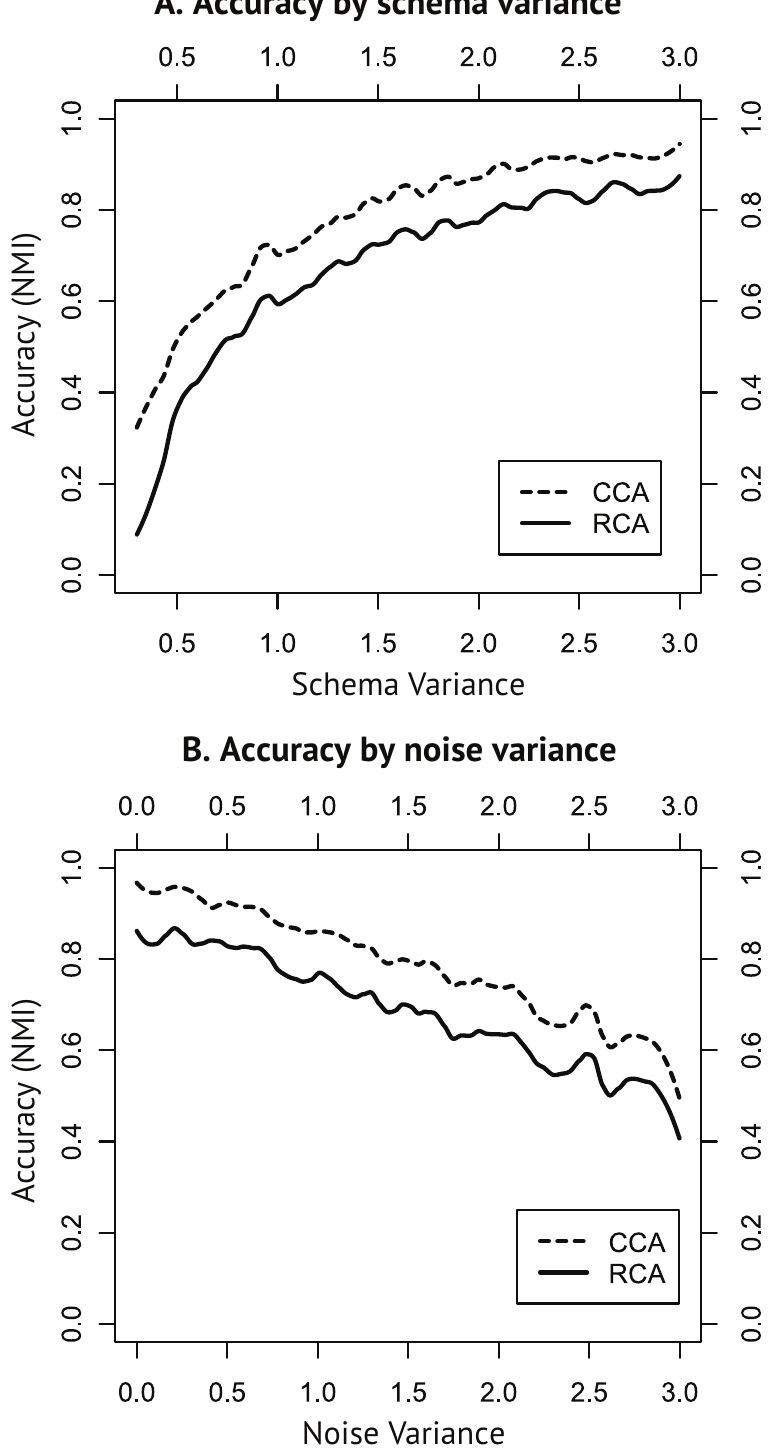
Figure 6: Loess curves comparing RCA and CCA accuracy based on 5,000 simulation runs. sociological science |